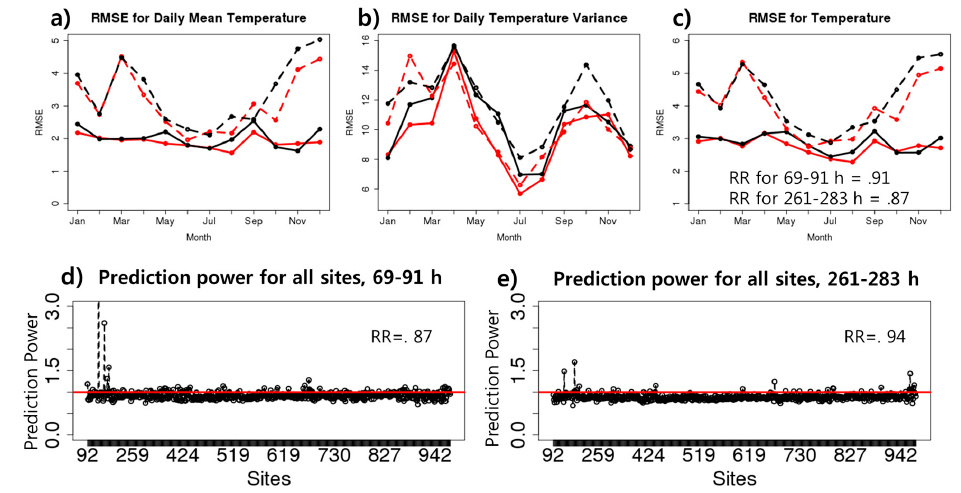
Figure 3. Bias corrected results for daily temperature. ( a ) Root mean square error (RMSE) of the daily temperature mean, ( b ) RMSE of the daily temperature variance, and ( c ) total temperature RMSE: 69–91 h uncorrected (solid black line), 69–91 h corrected (solid red line), 261–283 h uncorrected (dashed black line), 261–283 h corrected (dashed red line). The ratio of the root mean square (‘RR’) for each time slot is in the middle. The ratio of the mean corrected RMSE to the uncorrected RMSE for each site in ( d ) 69–91 h and ( e ) 261–283 h.